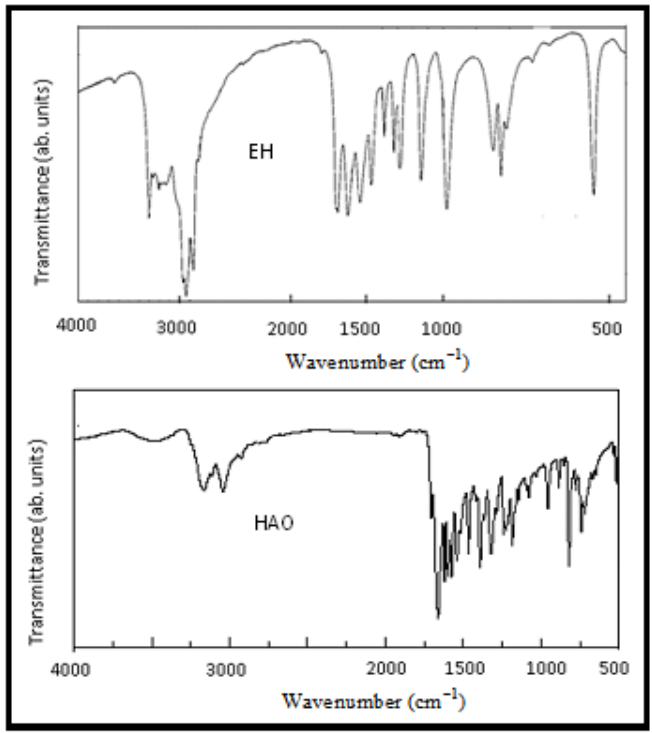
Figure 1. FT-IR spectra of EH and HAO, respectively.